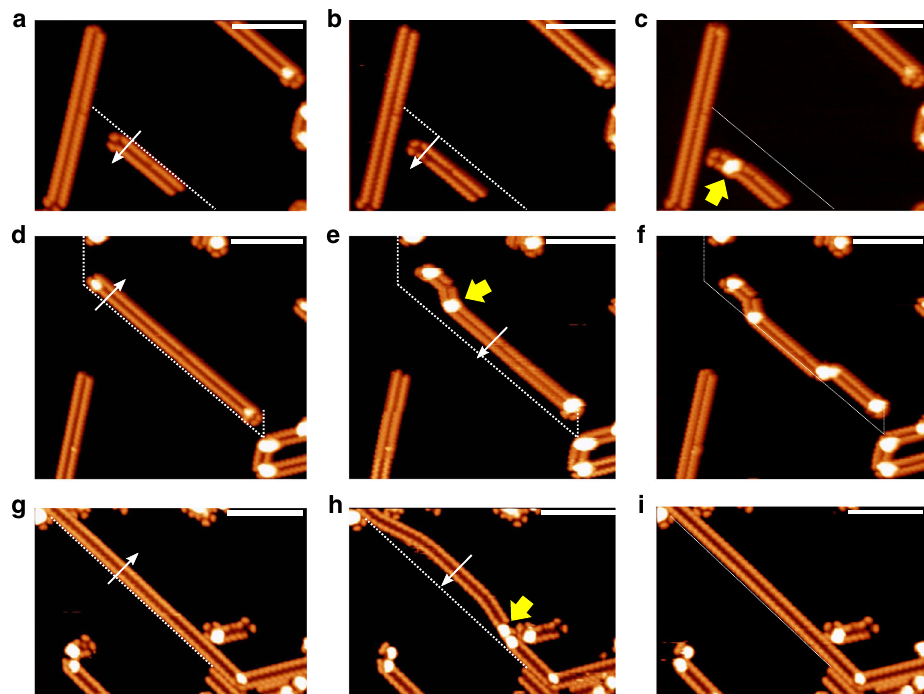
Fig. 4 STM images of lateral manipulation steps of polycyanine chains. The manipulations were performed with the STM tip at the positions and along the directions of the white arrows. The initial locations of the chains are indicated by the dashed lines. a , b Manipulation of a short isolated chain moves the entire chain across the surface, while retaining its orientation. b , c Additional manipulation of this chain leads to further displacement and formation of a bent with a bright protrusion (yellow arrow in c , which is attributed to an uplifted chain segment (see Supplementary Fig. 8). These protrusions are induced by sterical hindrance and also occur at sharp bends, that is, when a chain changes its orientation, as marked by yellow arrows in Fig. 3a. d – f Manipulation of a longer chain, resulting in the formation of bends with related protrusions, but no rupture of the chain. g – i Reversible manipulation of a chain anchored at both ends. The induced protrusions appearing in h are reversed by pushing in the opposite direction (see i ). Tunneling parameters: a – f , U = − 3.6 V, I = 0.09 nA; g – i , U = − 3.7 V, I = 0.12 nA. All the scale bars are 10